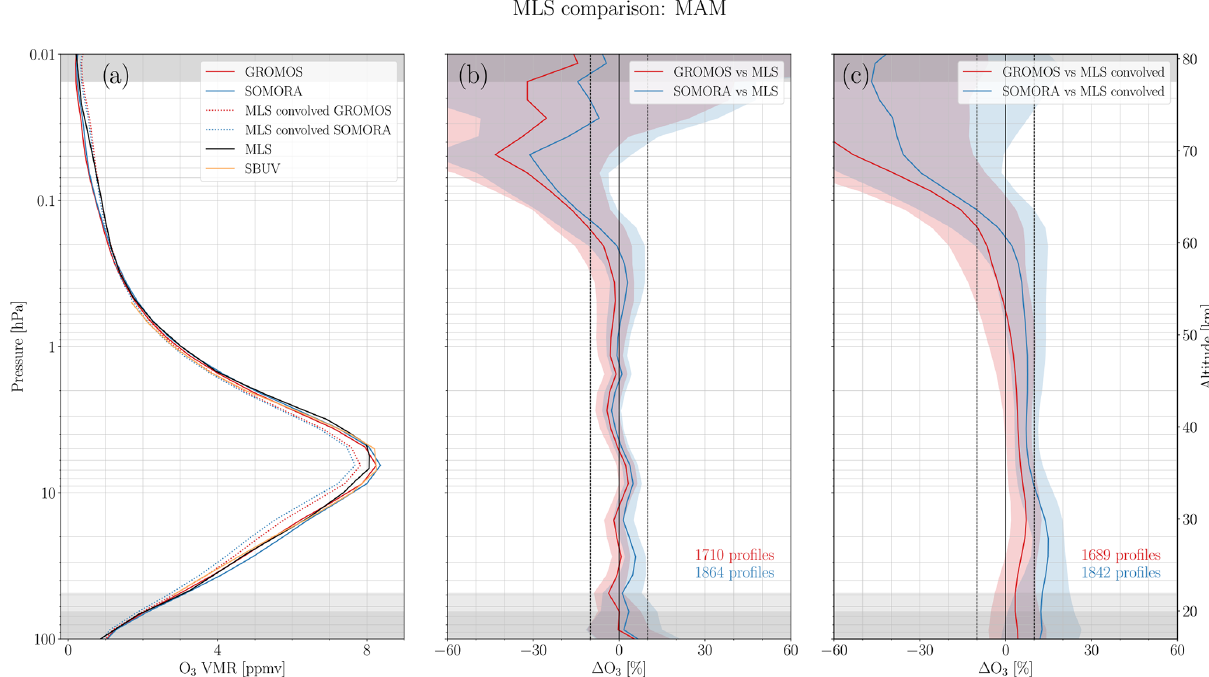
Figure C1. The same as Fig. 11 but for spring (March, April and May).